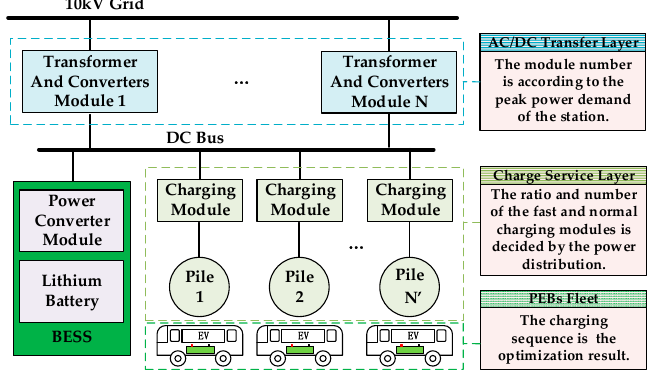
Figure 6. Schematic figure of the battery energy storage system (BESS) configuration. Table 10. Parameters of the case. SOC—state of charge. Parameter